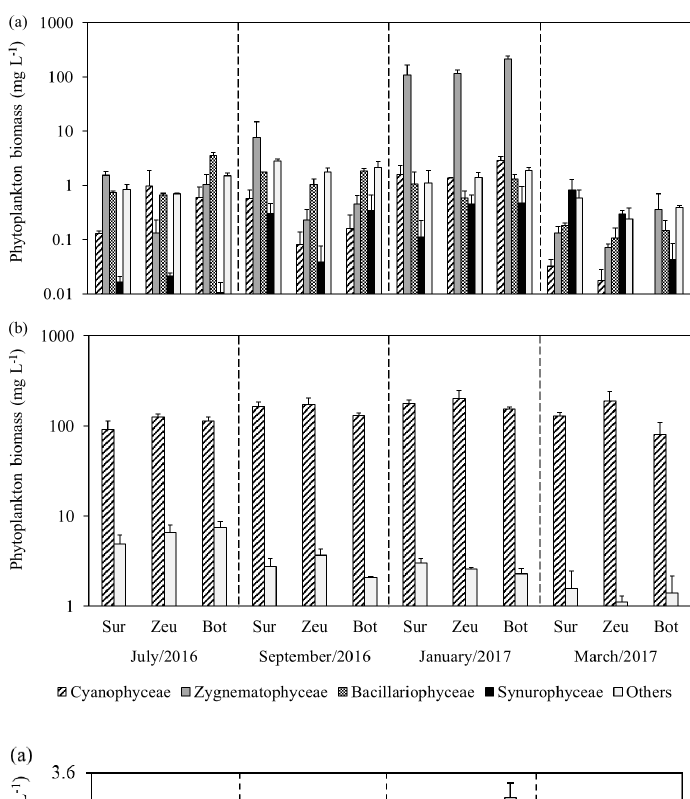
Figure 4. Biomass of diazotrophic and non- diazotrophic filamentous and colonial cyanobacteria in the mesotrophic (Tabocas; a) and supereutrophic (Tapacurá; b) reservoirs between July/2016 and March/2017 at different depths. Sur = surface; Z = euphotic zone limit; Bot = bottom. Vertical lines represent the standard error of the mean (±SEM).